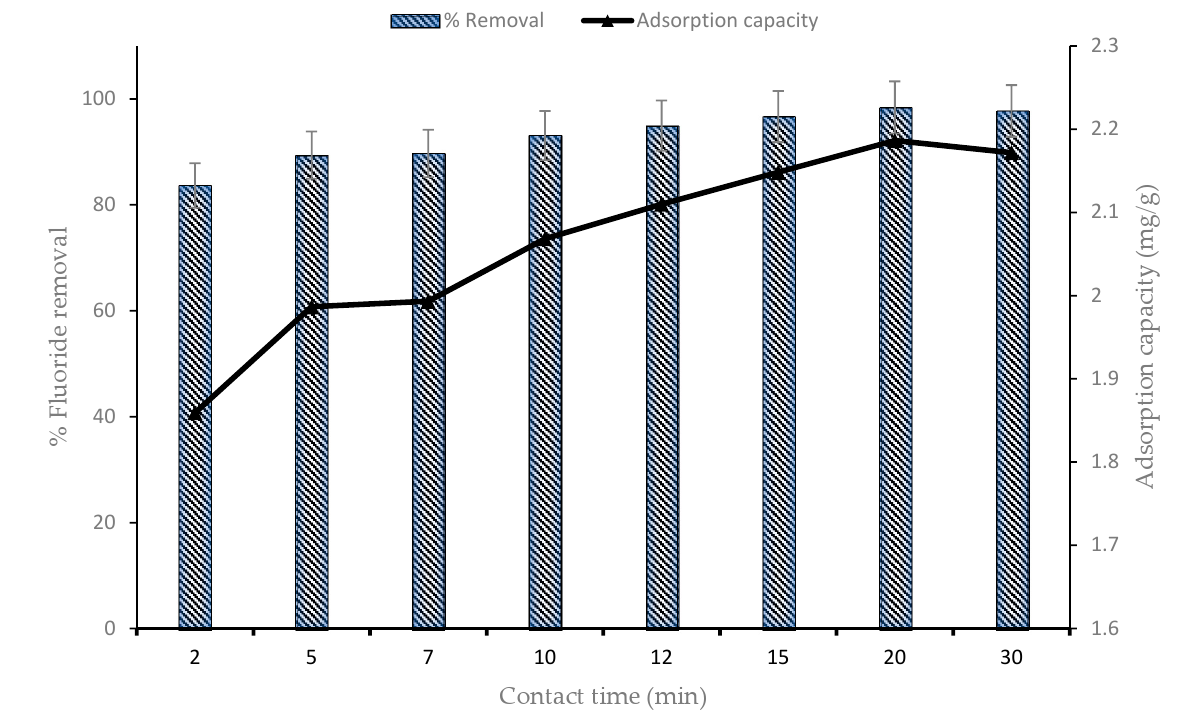
Figure 6. Effect of contact time on CNF-AgMgOnHaP adsorbent. (Experimental conditions: dosage, 0.225 g; volume, 50 mL; initial concentration, 10 mg/L; pH, neutral; temperature, 298 K and shaking speed, 250 rpm).